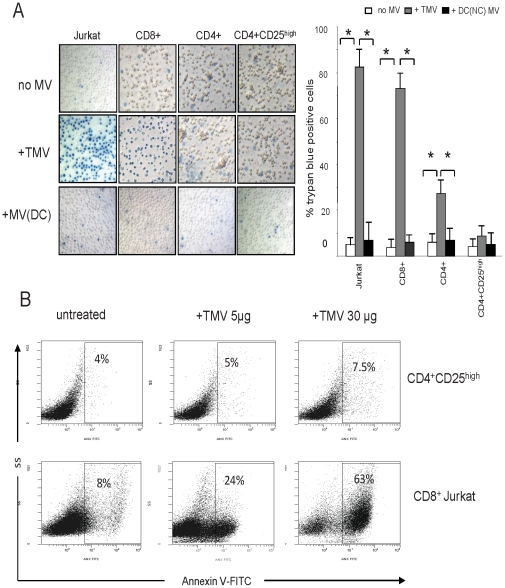
CD4+CD25high Treg are resistant to TMV-induced death.(A) Trypan blue positive cells after 6 h incubation ± TMV or DC-derived MV in primary T-cell subsets and CD8+ Jurkat cells (mag ×200) *p<0.001. (B) Percentages of ANXV binding to fresh CD4+CD25high T cells or CD8+ Jurkat cells incubated ± TMV for 6 h. The data are representative dot plots from one of five independent experiments.